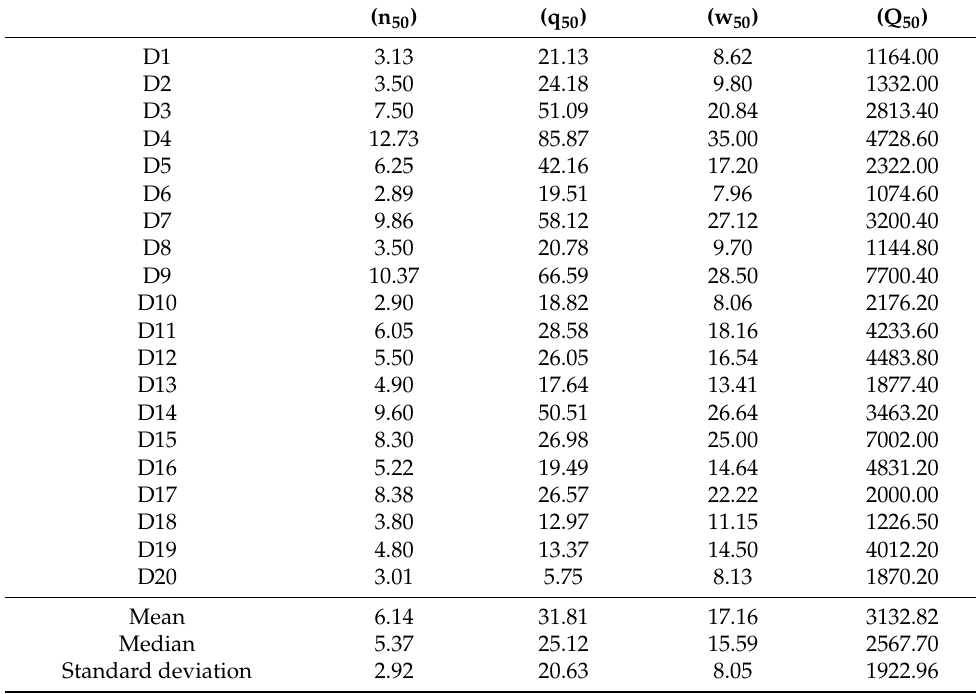
Table 4. The standardized airtightness parameters for the tested